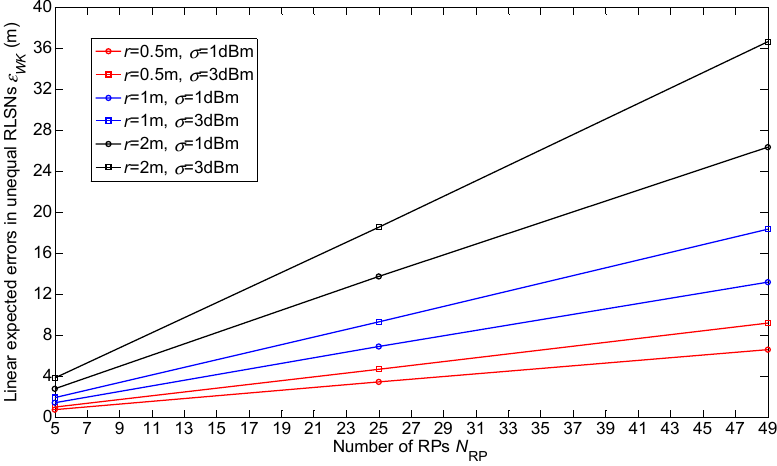
Figure 9. Linear expected errors with variations of r and σ in unequal-weighted RLSNs ( K =